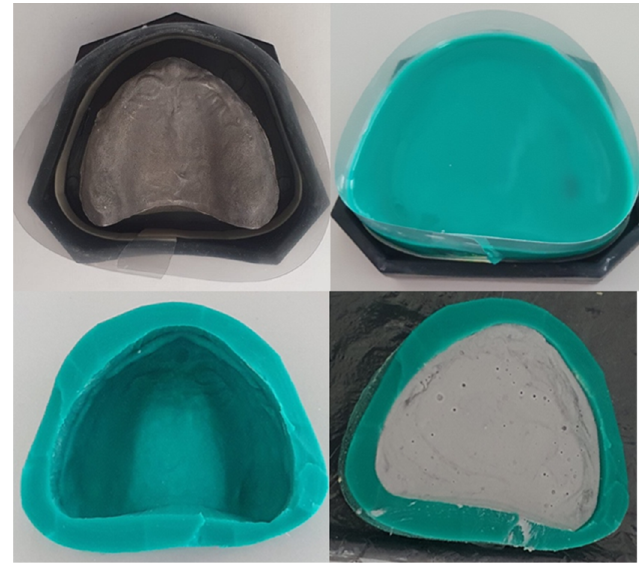
Figure 3. Casting process of the replicated model.